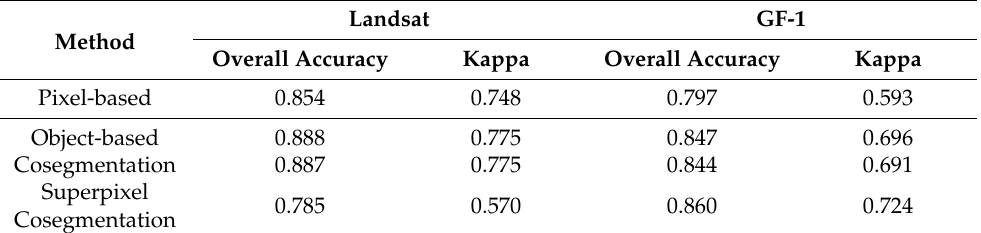
Table 8. Comparison of the accuracy of four change detection methods.